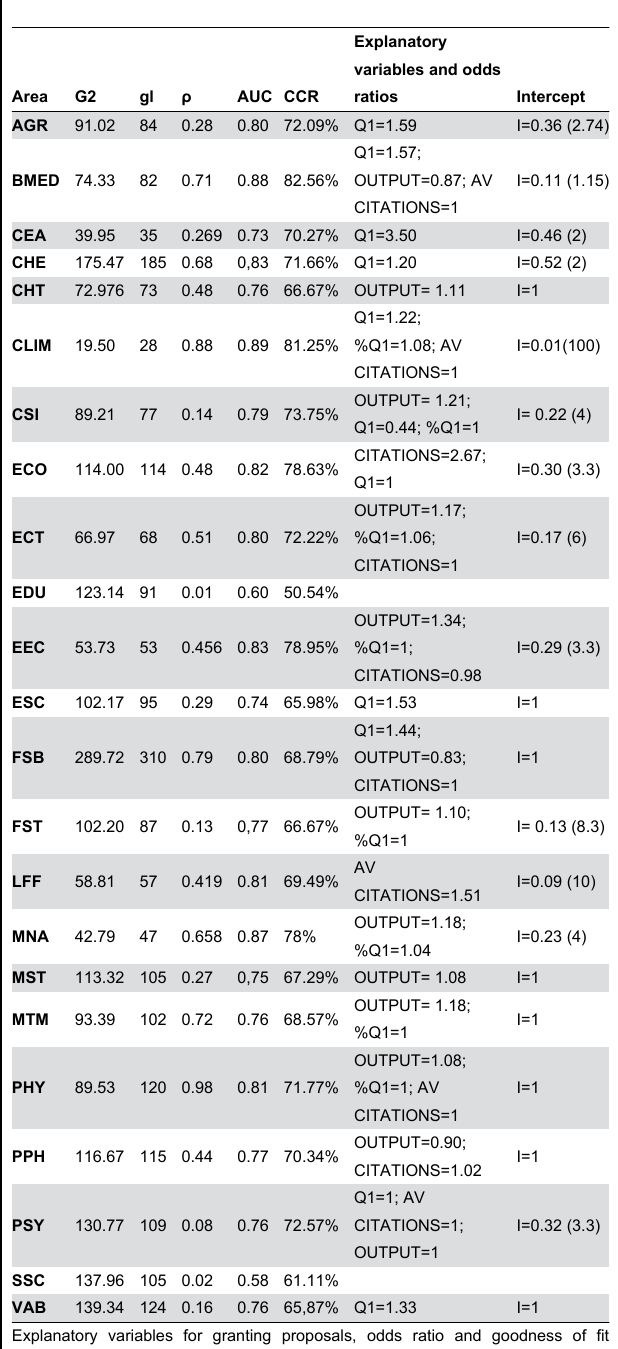
Table 7. Stepwise logistic regression analysis by